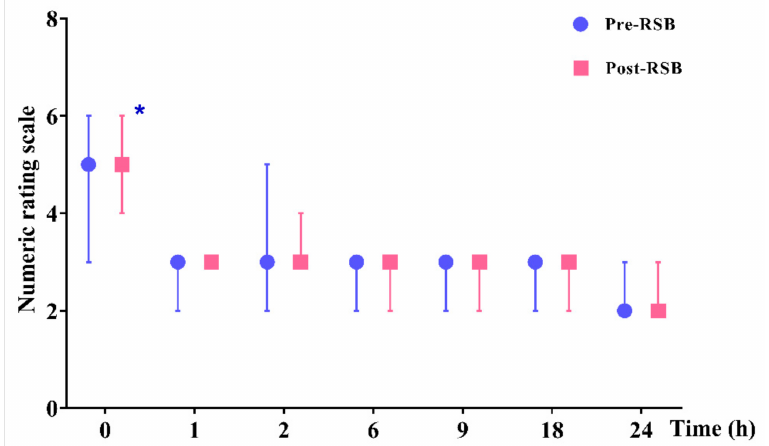
Figure 3. Postoperative pain scores (numerical rating scale 0 to 10) during 24 h after surgery. Data are expressed as median (interquartile range). * p < 0.05. Abbreviations: Pre-RSB, preoperative rectus sheath block; Post-RSB, postoperative rectus sheath